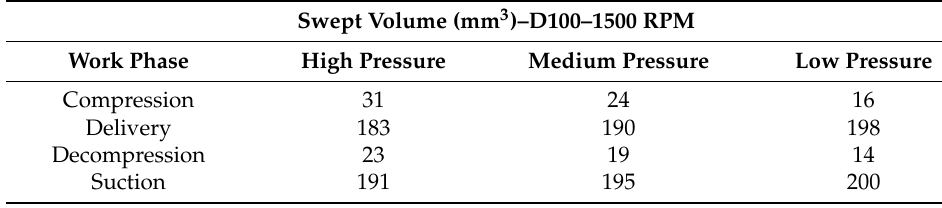
Table 5. Extent of pump work